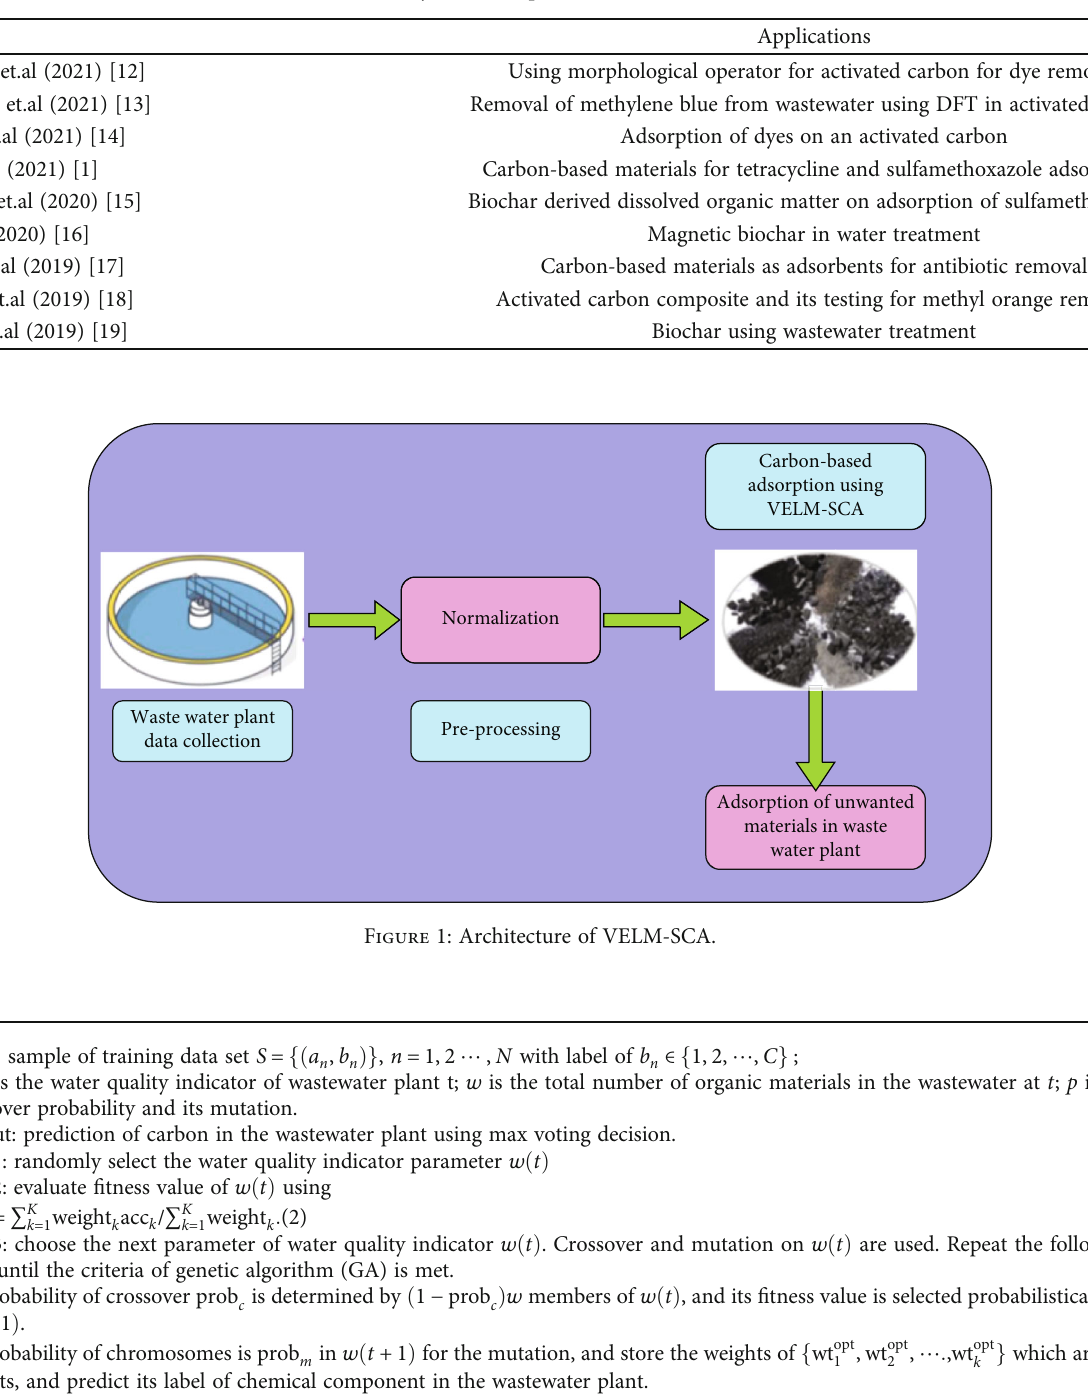
Table 1: Survey on techniques used in activated carbon.